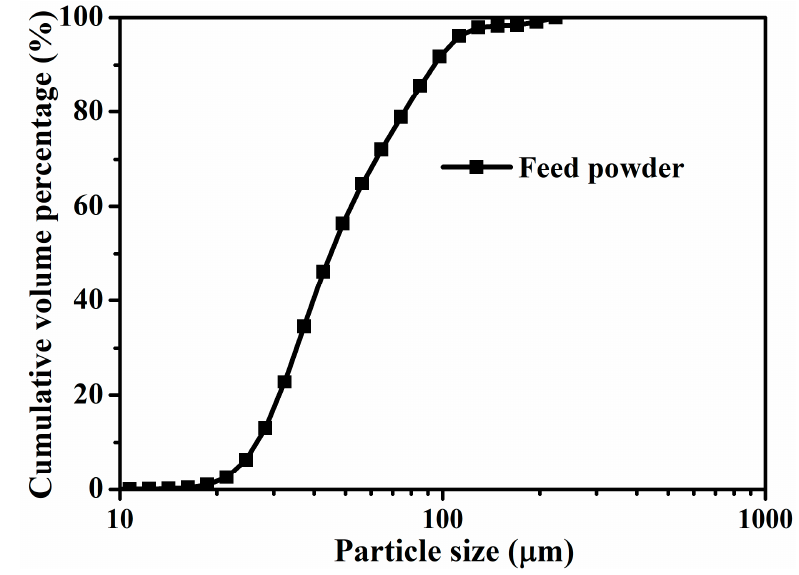
Figure 1. Particle size distribution of the SAC305 feed powder.